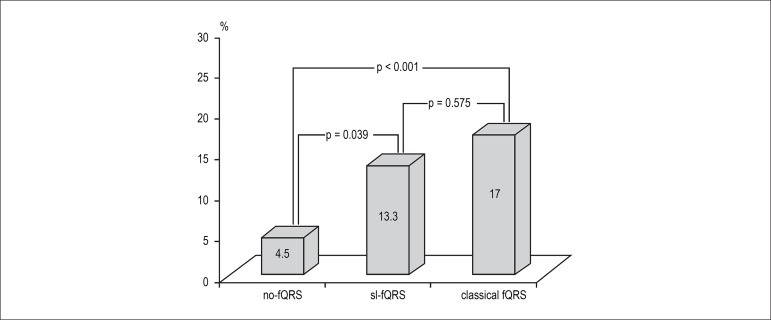
Comparisons among groups in terms of in-hospital mortality.